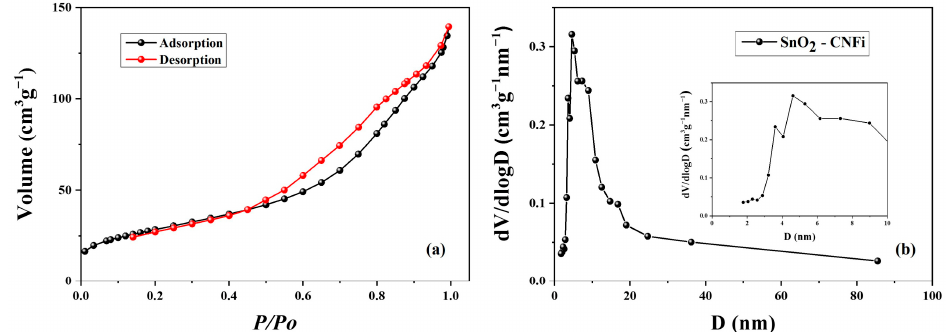
Figure 3. ( a ) Nitrogen adsorption–desorption isotherm and ( b ) BJH pore size distribution of the nanocomposite.